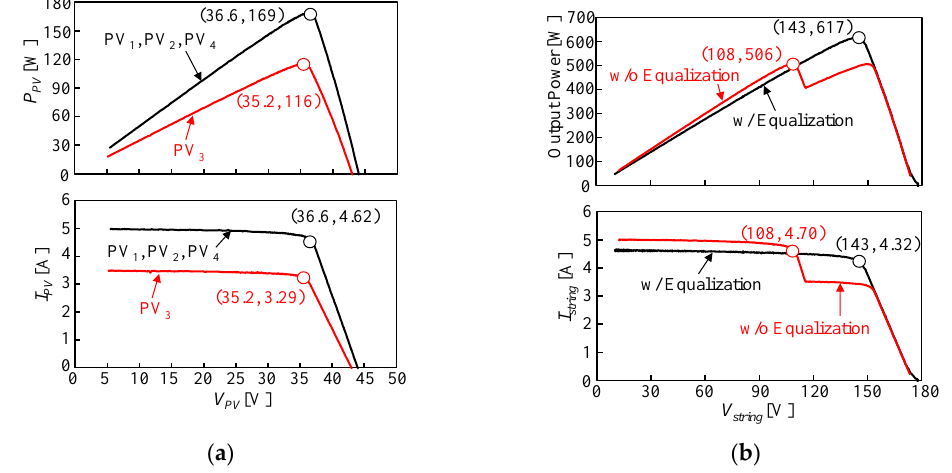
Figure 15. Experimental results of laboratory testing. ( a ) Individual panel characteristics used for experiment; ( b ) Measured string characteristics with/without proposed DPP converter.